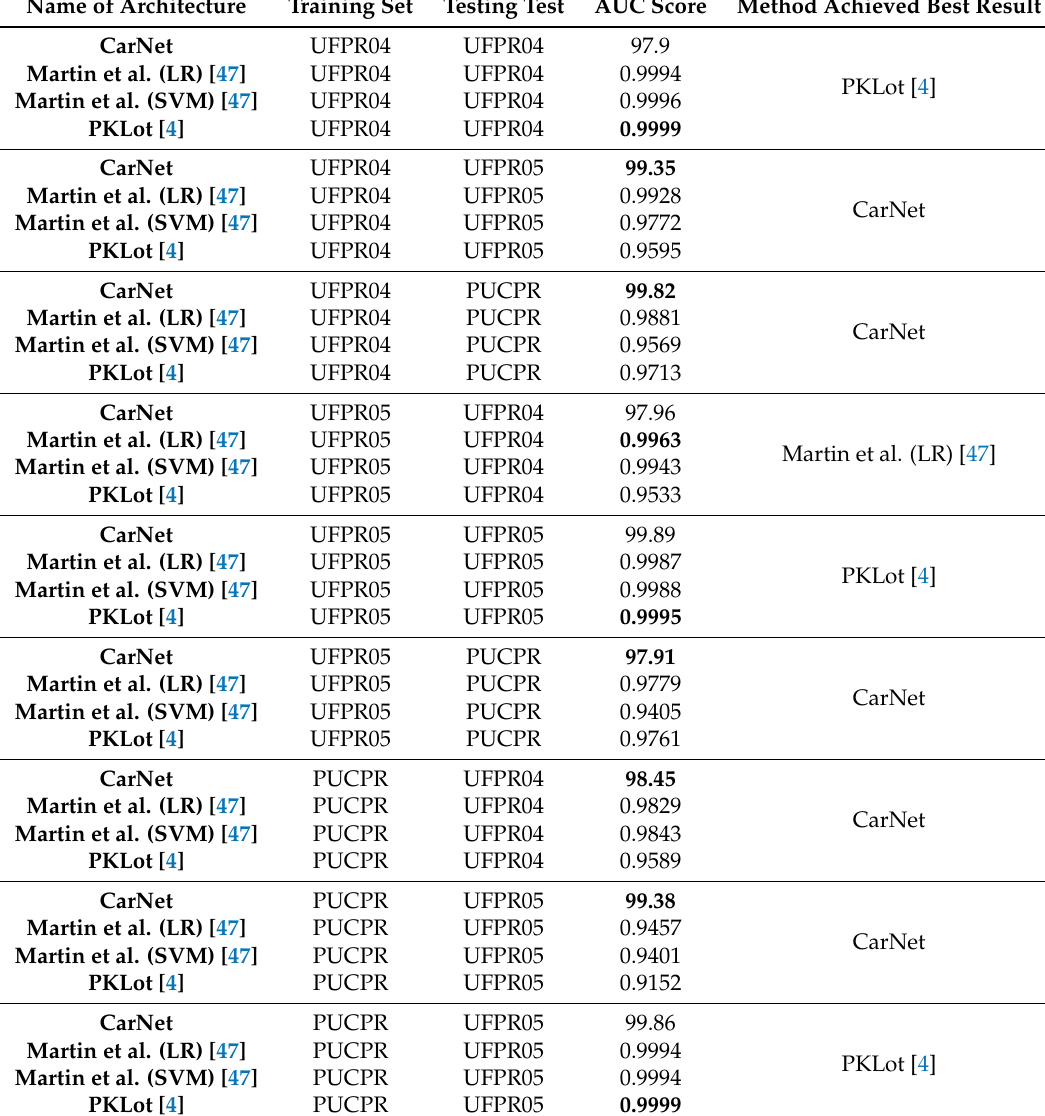
Table 15. Comparison of AUC scores of CarNet with Martin et al. (LR) [47] and Martin et al. (SVM) [47] on PKLot